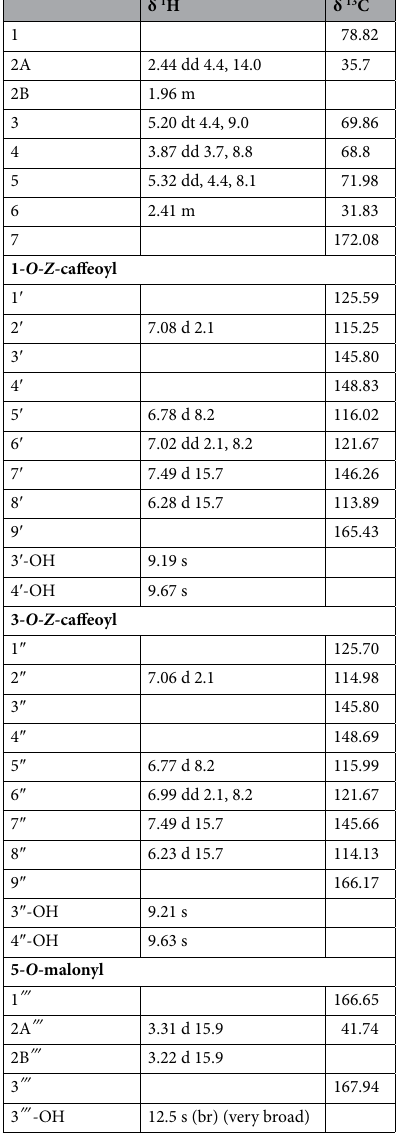
Table 2. 1 H and 13 C NMR chemical shift values (ppm) and coupling constants (Hz) of 1,3-dicaffeoyl-5- malonyl-δ-quinide ( 1 ) isolated from Anthriscus cerefolium recorded in DMSO-D 6 at 298